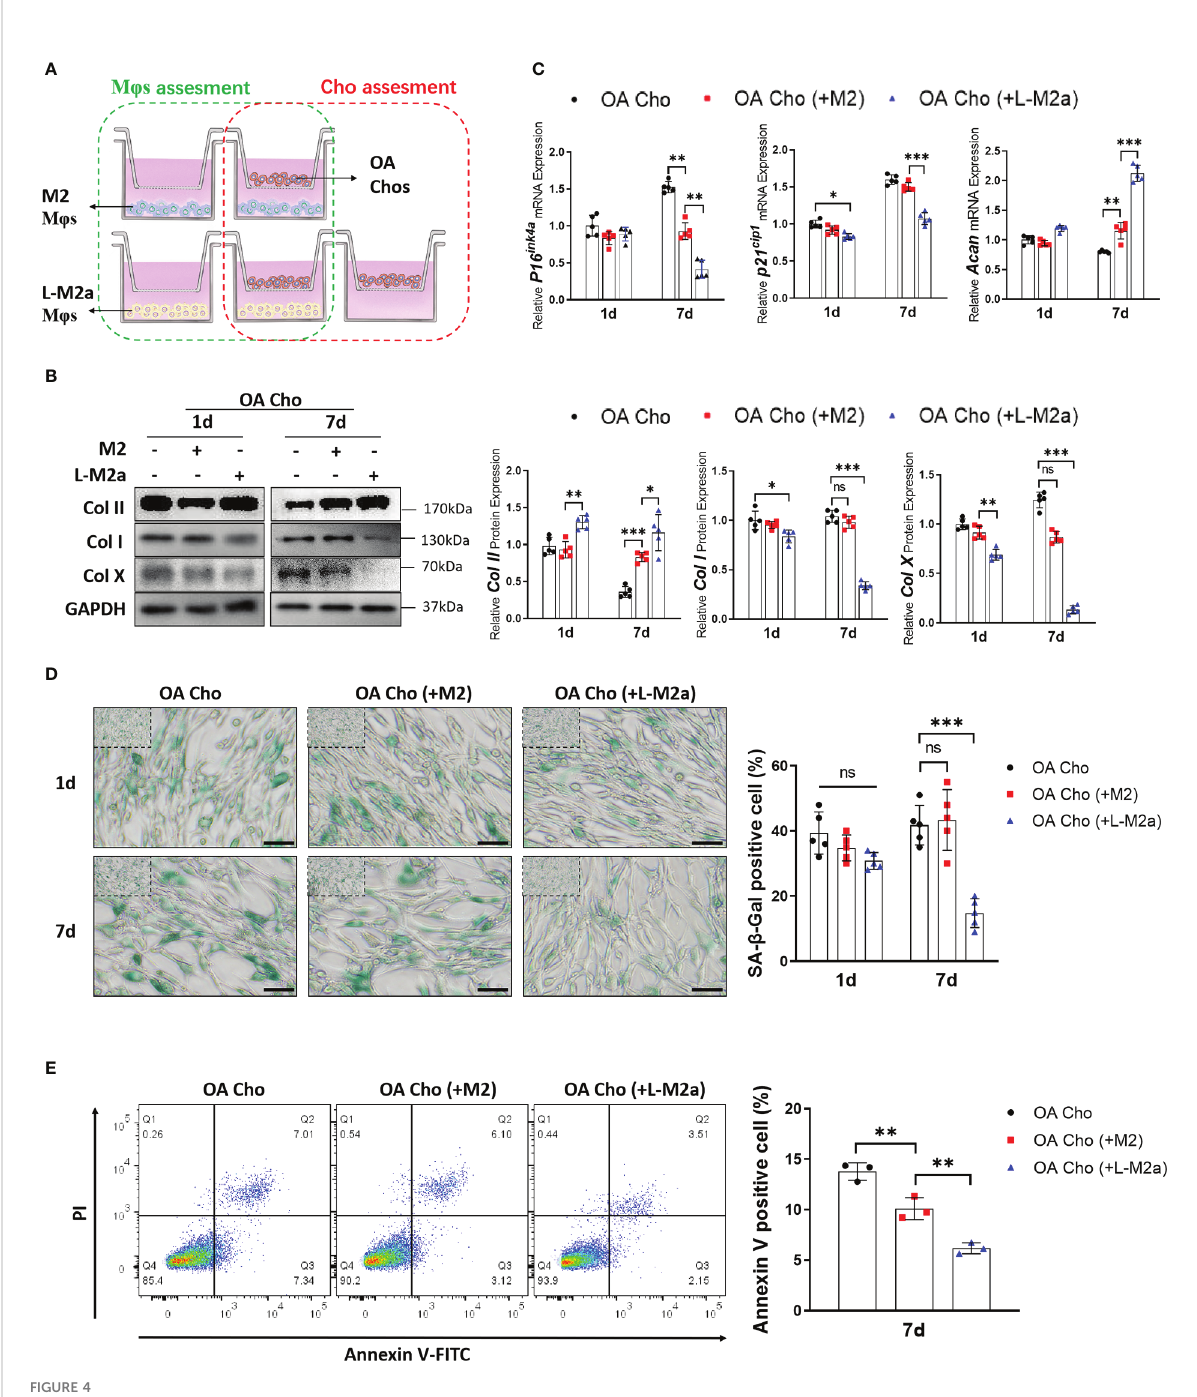
FIGURE 4 L-M2a M j s exhibited anti-degenerative effects in crosstalk with OA-chondrocytes. (A) Illustration of transwell co-culture system of M j s and OA chondrocytes. (B, C) Assessment of collagen synthesis ability (B) , in fl ammation factors and senescence markers (C) in OA chondrocytes co- cultured with control, M2 or L-M2 cells for 1 and 7 days. (D) Staining of SA- b -Gal (green, bar= 100 m m) in OA chondrocytes co-cultured with control, M2 or L-M2a M j s for 1 and 7 days. (E) Apoptosis rates for different M j -stimulated OA chondrocytes after 7 days coculture were analyzed by fl ow cytometry using annexin V-FITC/PI apoptosis analysis. ∗ p < 0.05; ∗∗ p < 0.01; ∗∗∗ p < 0.001. ns, no signi fi cance; M j , macrophage; L-M2a M j , locked M2a macrophage; Cho,